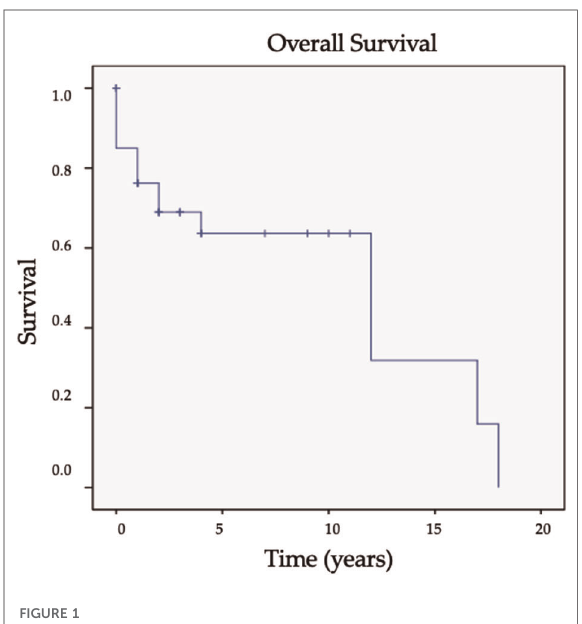
FIGURE 1 Overall survival curve (cross represents the censored data).